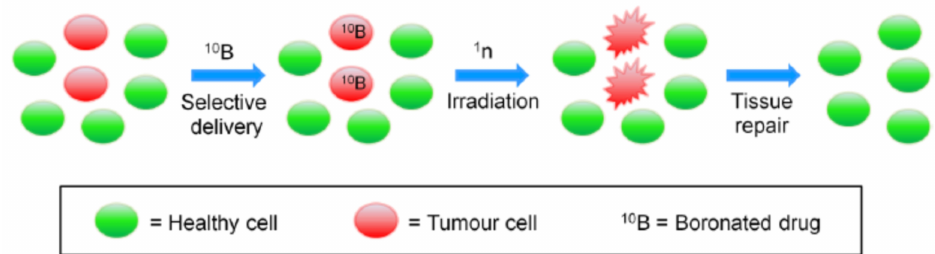
Figure 1. BNCT steps: selective delivery of 10 B-drugs to tumour cells is followed by irradiation with slow neutrons ( 1 n), leading to tissue repair. (Adapted from Calabrese et al.